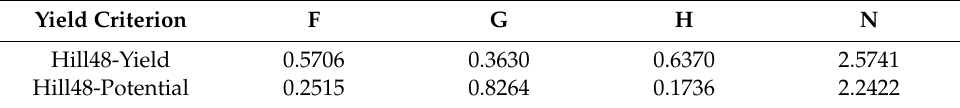
Table 4. Hill’s 48 coe ffi cients for AA 2090-T3 sheet.